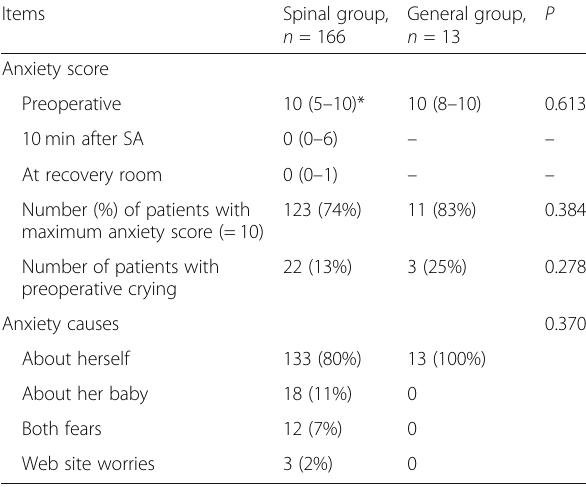
Table 3 Preoperative anxiety and its etiology